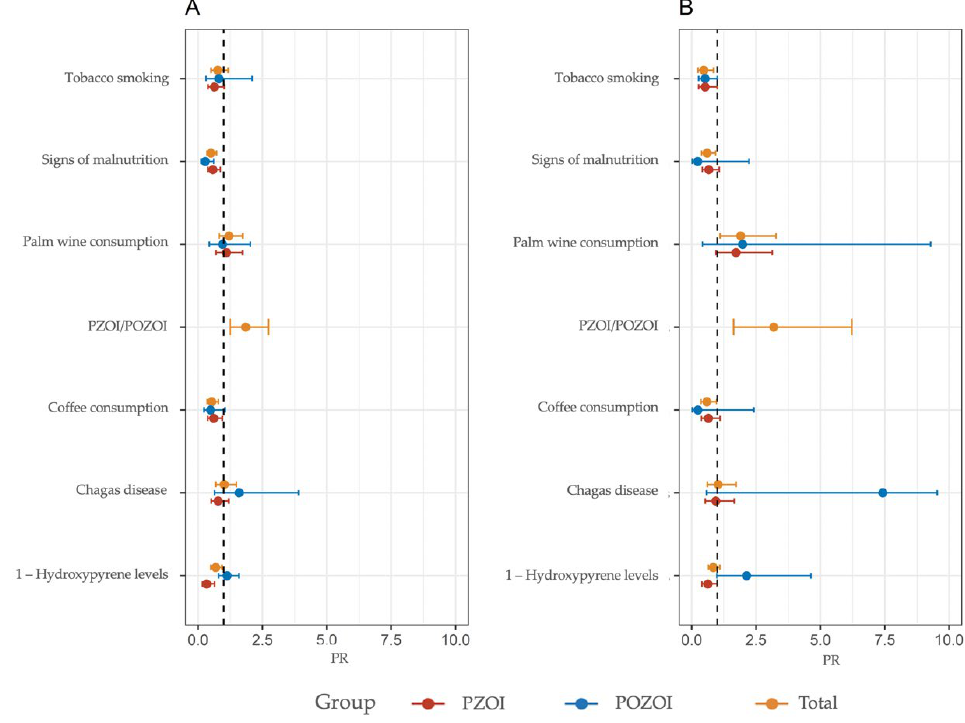
Figure 3. PR for NPB frequency based on a Poisson regression model for PZOI and POZOI groups. ( A ) Unadjusted and ( B ) adjusted for covariates.